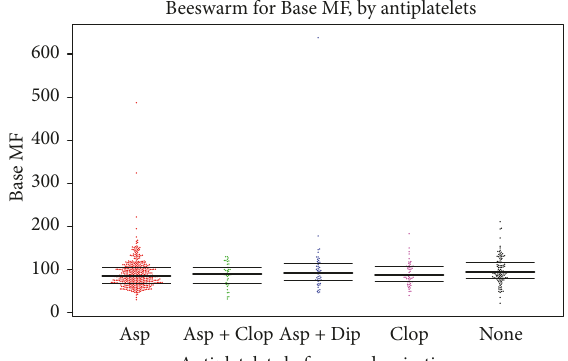
Figure 3: P-selectin with no stimulation, by antiplatelet medication taken prior to randomisation. Data are median fluorescence (MF). The horizontal lines show the median and interquartile values. Table 4: P-selectin (median fluorescence) in response to ADP and arachidonic acid (AA), by antiplatelet medication taken prior to randomisation, whether before or after stroke/TIA. Data are number (%) or mean (standard deviation). Comparisons by Chi-square test or one-way analysis of variance.